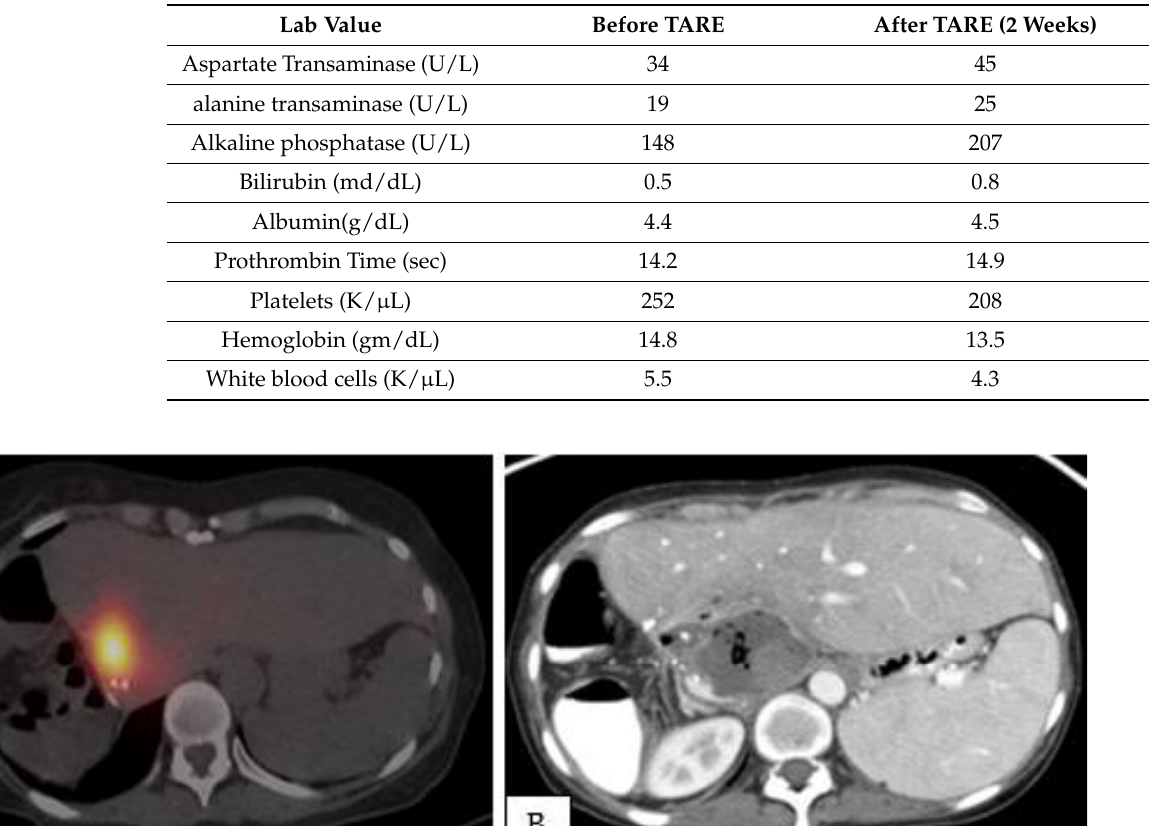
Table 2. Laboratory values before and after the TARE for the patient who developed Liver abscess (Child Pugh A).